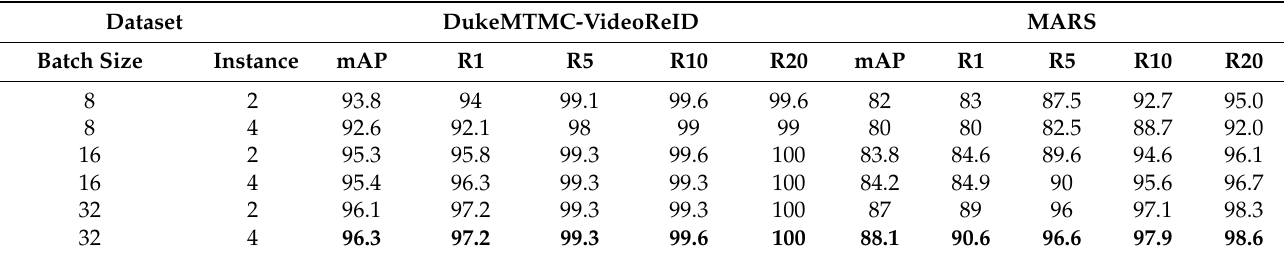
Table 5. Comparing Our Model’s Accuracy Using Different Batch Sizes and